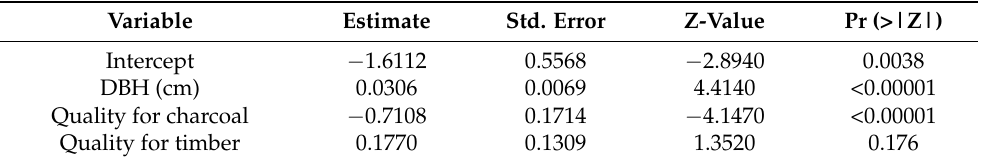
Table 3. The result of the generalized linear model (GLM) with logit link to predict probabilities of illegal logging for a given tree.